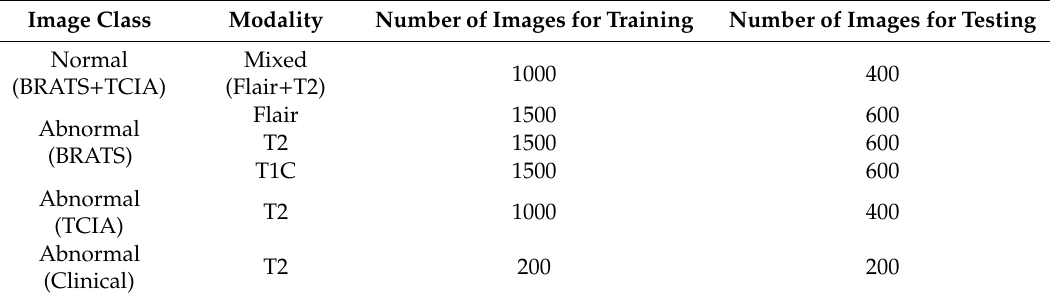
Table 1. Test images considered in this